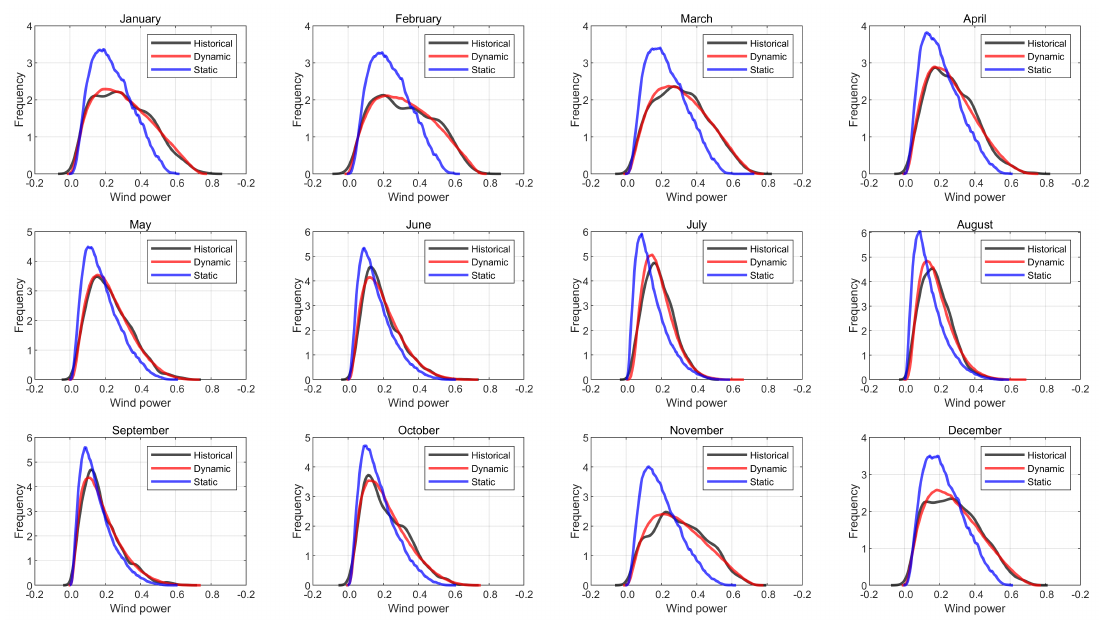
Figure 8. Monthly comparison of density distribution